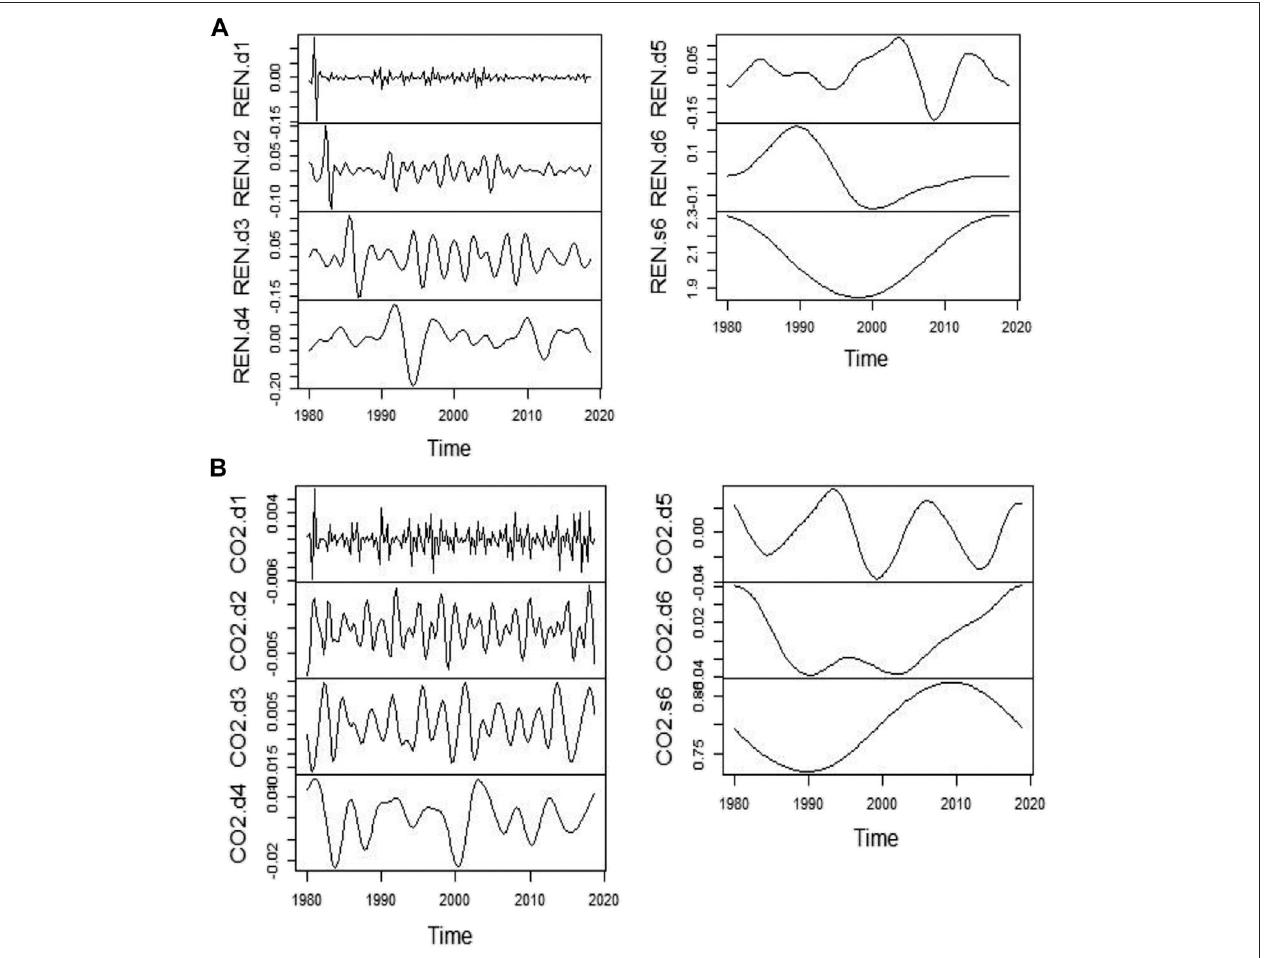
FIGURE 4 | (A) REN wavelet trans fi guration. (B) CO 2 wavelet trans fi guration. (C) GDP wavelet trans fi guration. (D) GLO wavelet trans fi guration. (E) TI wavelet trans fi guration.